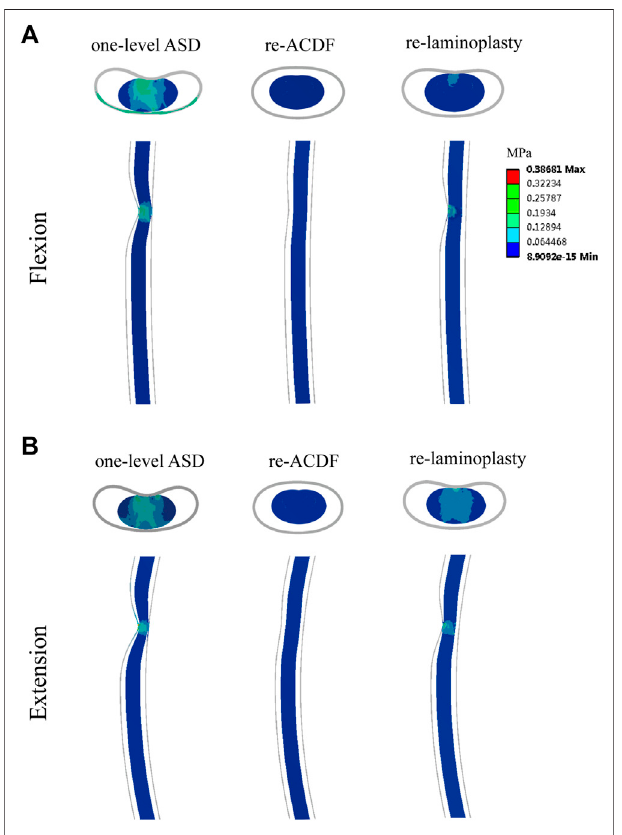
FIGURE 9 | Distribution of von-Mises stress in the spinal cord of re- ACDF and re-laminoplasty models for the treatment of two-level ASD. (A) Stress distribution in fl exion. (B) Stress distribution in